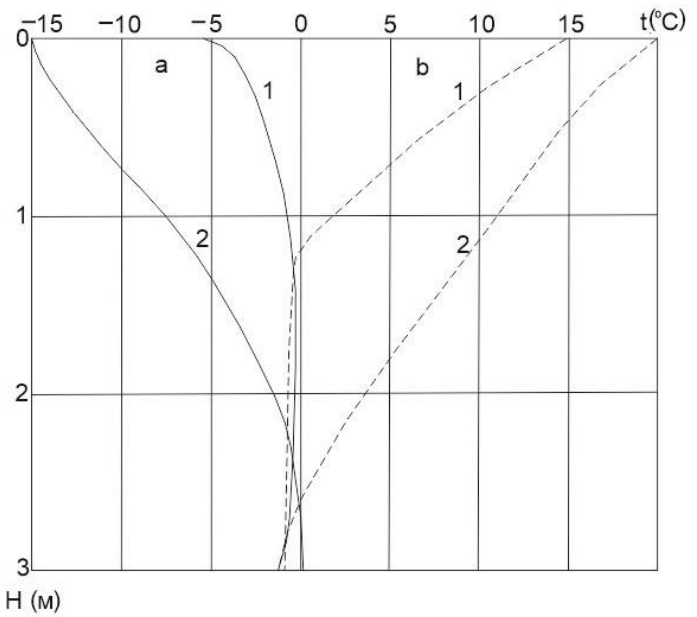
Figure 8. Average monthly soil temperature (t) in the area of the natural floodplain (1) and embank- ment (2) in January (a) and in July (b) [36].